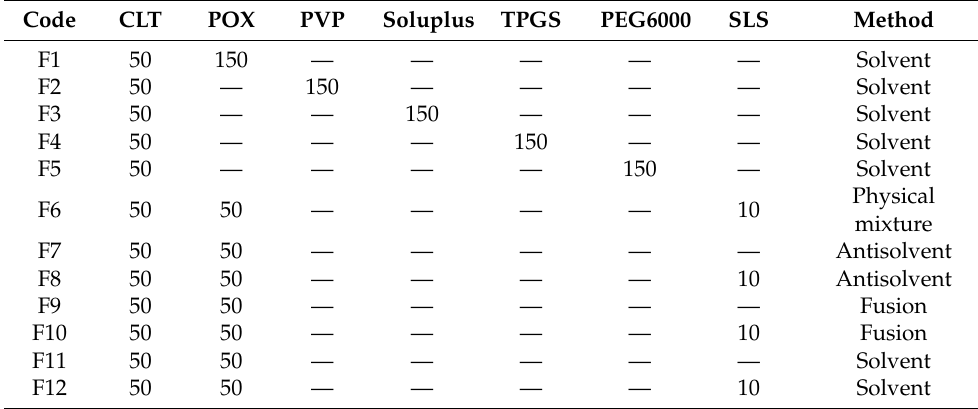
Table 1. Formulation compositions (mg) and preparation methods of